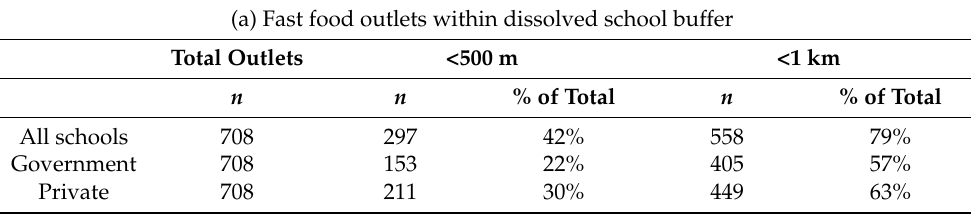
Table 3. Fast food outlets within buffer and schools with at least one outlet in Riyadh City. (a) Fast food outlets within dissolved school